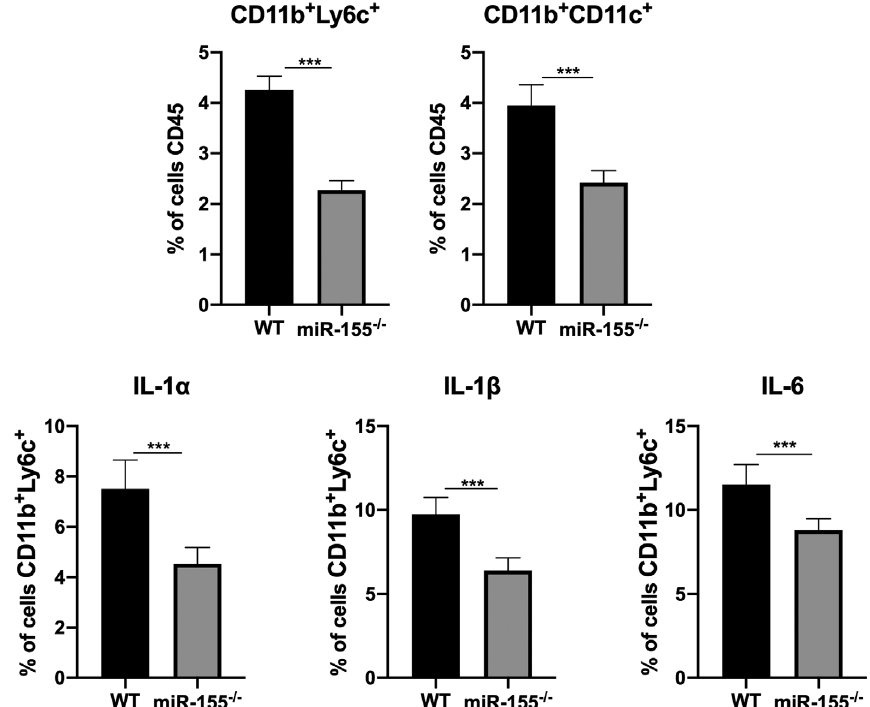
Figure 5. Decreased accumulation of splenic in fl ammatory monocytes and DCs and expression of pro-in fl ammatory mediators in miR- 155KO-infected mice. Flow cytometric analysis of splenic in fl ammatory monocytes and DCs of parasite infected-WT and miR-155 (cid:1) / (cid:1) mice. The expression of pro-in fl ammatory mediators was analysed by qRT-PCR. Data are presented as a mean ± SD of three independent experiments. The asterisks indicate the statistical signi fi cance of difference between WT and miR-155 (cid:1) / (cid:1) mice. *** p < 0.001; ** p <